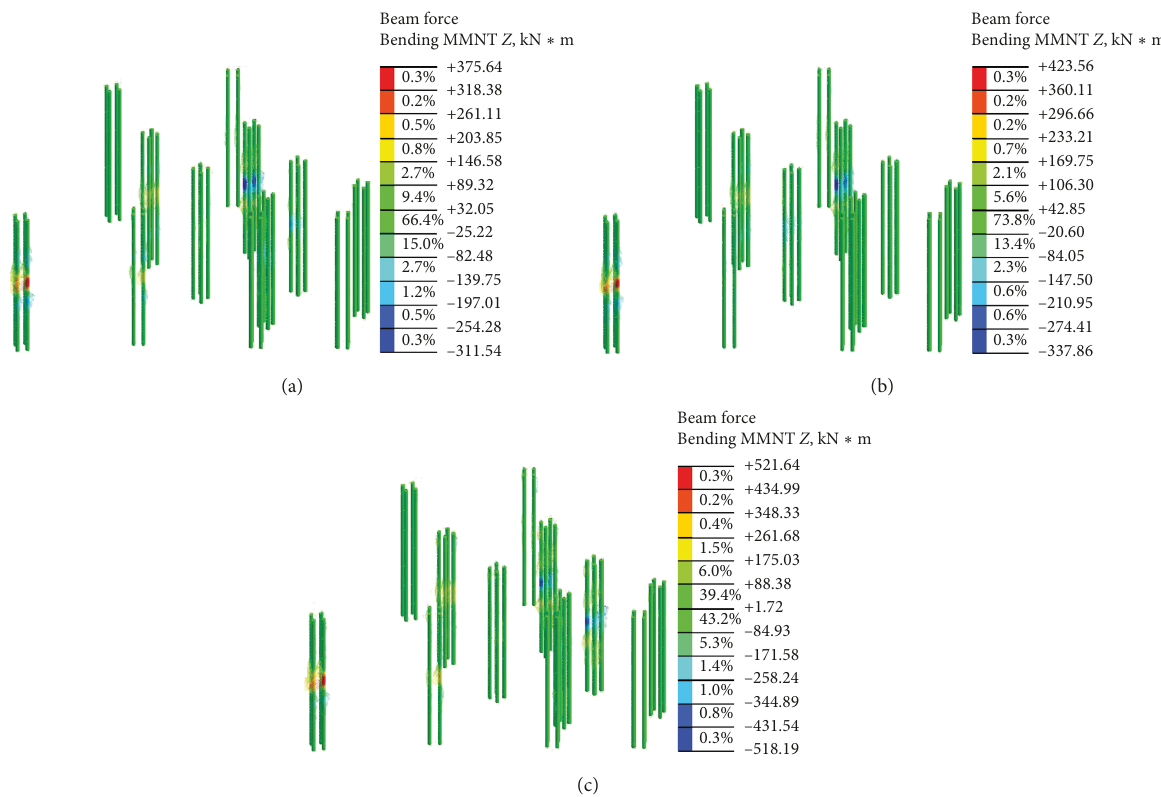
Figure 16: Bending moment of piles: (a) deep-hole grouting; (b) pile foundation underpinning; (c) without